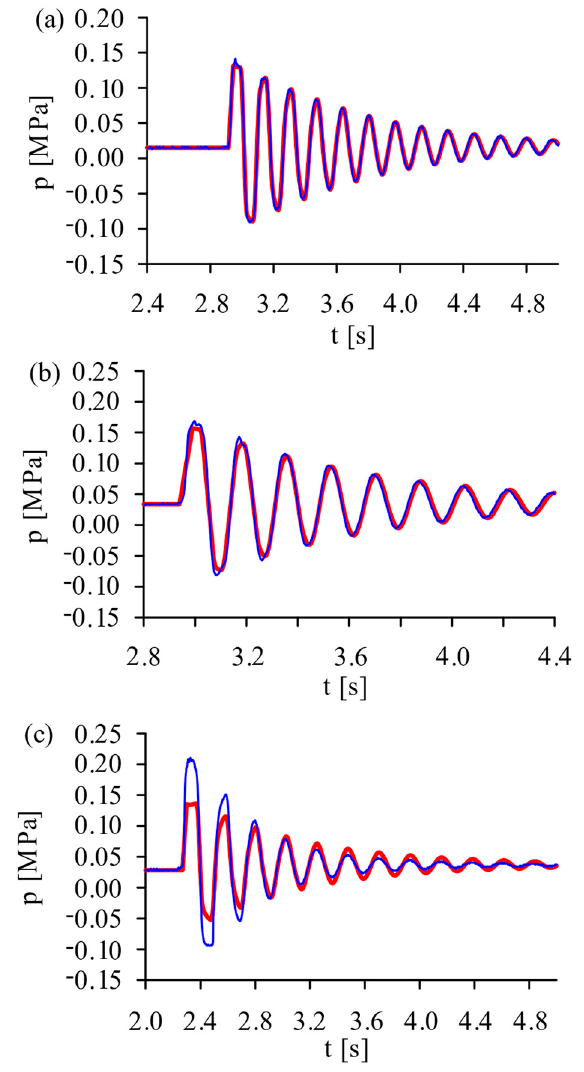
Figure 6. Pressure characteristics: measured (blue line) and calculated (with ρ = ρ m , a = a emp ) (red line): ( a ) water; ( b ) slurry, C V = 0.007; ( c ) slurry, C V = 0.039.